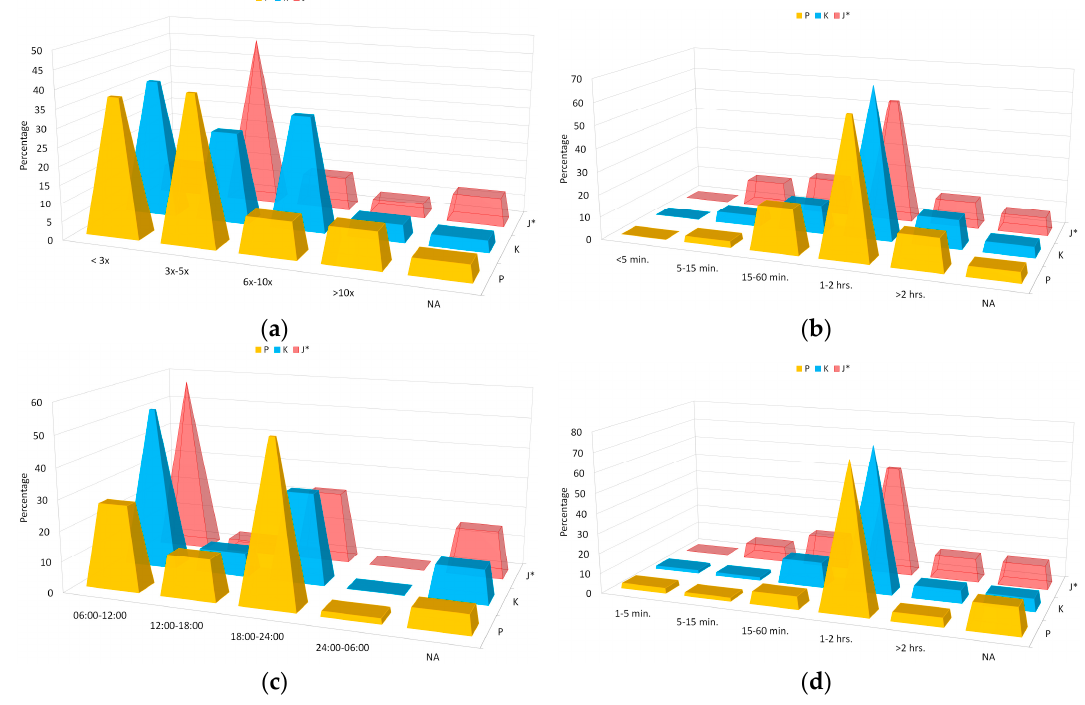
Figure 6. The proportion of respondents’ answers to the following questions, in percentages: ( a ) On average, how often do you experience blackouts in a month? ( b ) On average, how long is the duration of the blackouts that you experience? ( c ) At what time of day would a blackout event incur the most losses for you? ( d ) On average, how long is the duration of a blackout that would incur any losses for you? P: Pekanbaru, K: Kupang, J: Jayapura *, NA: No answer. * Data from Jayapura is less representative.